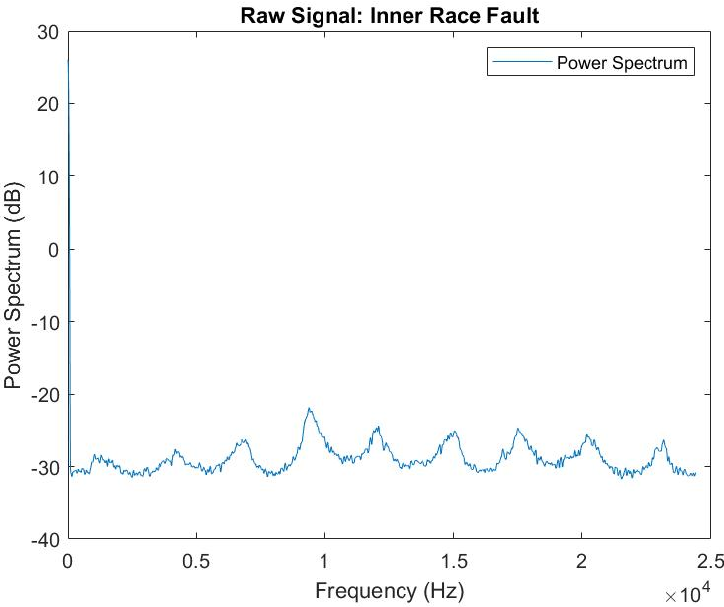
Figure 11. Raw signal of the damaged inner ring in frequency domain.